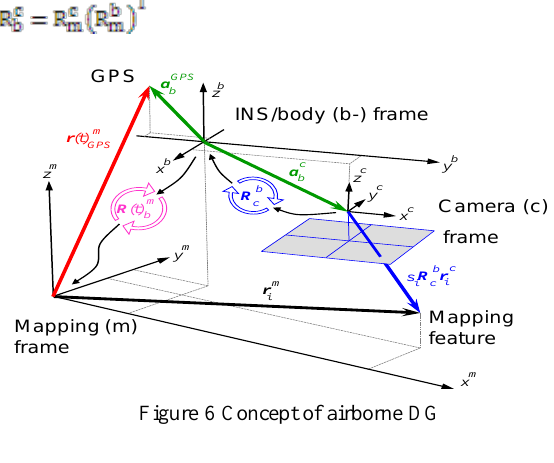
Figure 6 Concept of airborne DG